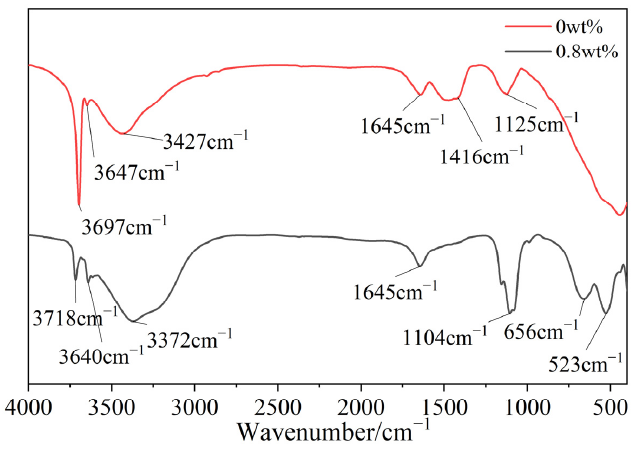
Figure 10. FTIR spectra of products with different CS contents.